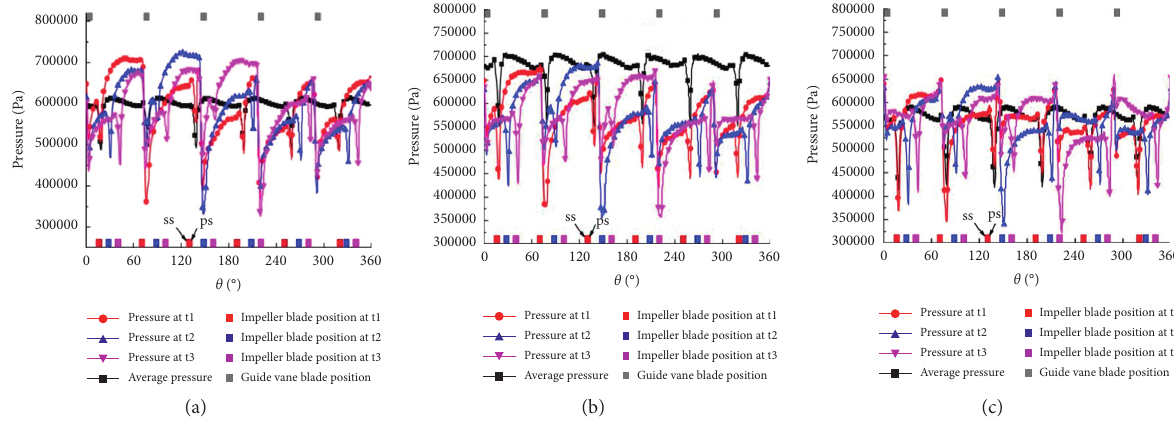
Figure 8: The instantaneous and average pressure distribution of the section along the circumferential direction of the impeller outlet under different flow conditions. (a) 0.8 Q / Q d . (b) 1.0 Q / Q d . (c) 1.2 Q / Q d